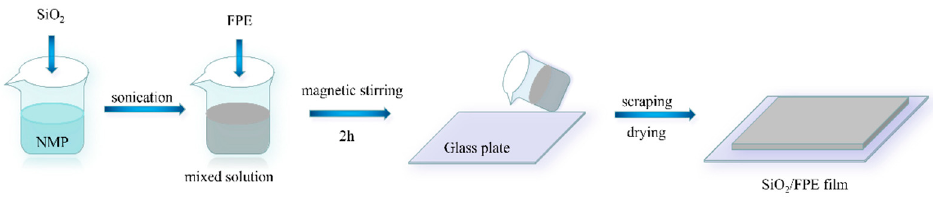
Figure 1. Schematic diagram of SiO 2 /FPE composite solution-blending preparation method.